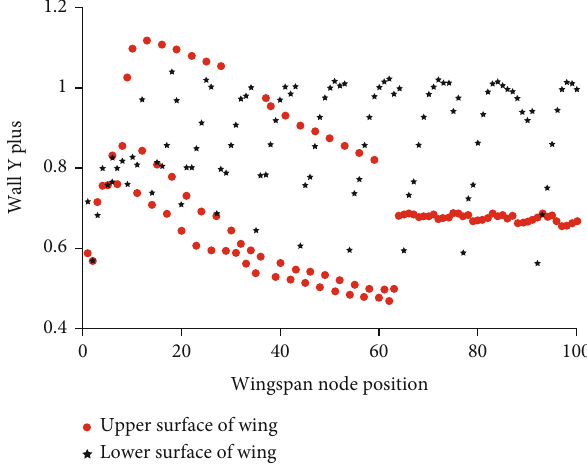
Figure 5: Mesh independence veri fi cation results.